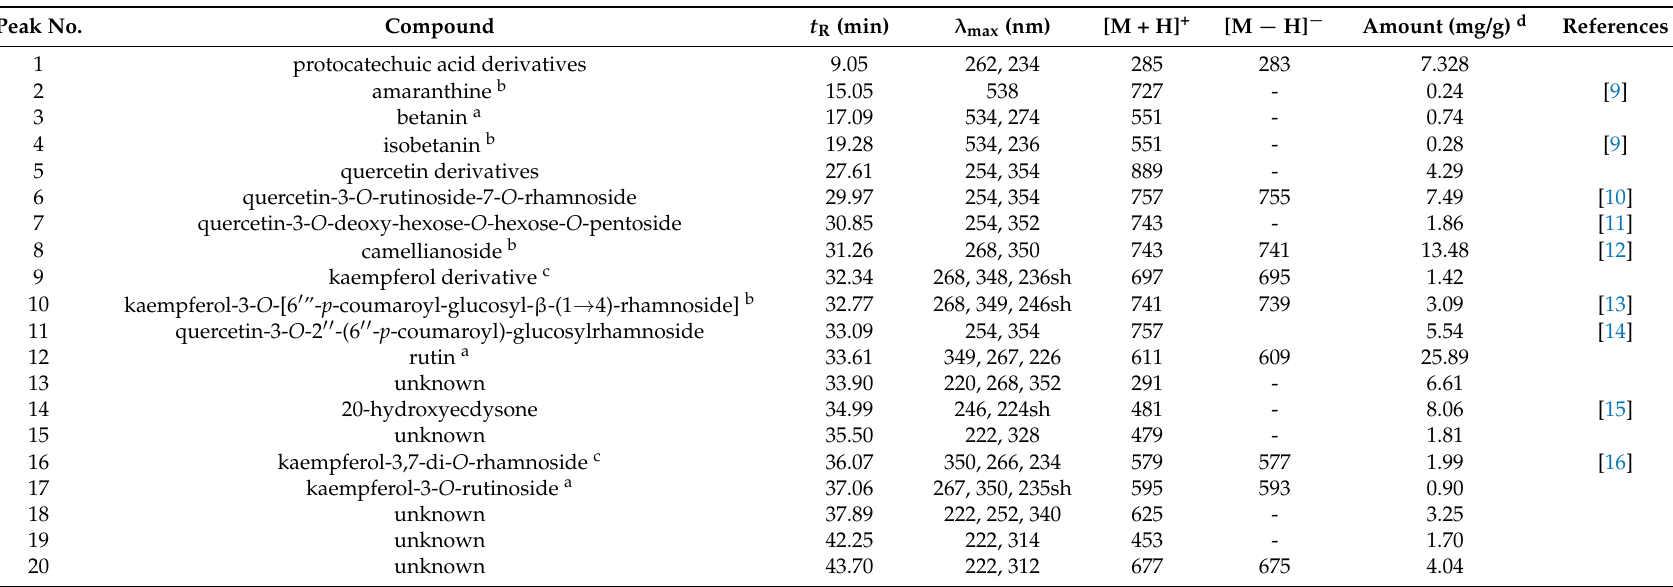
Table 1. Retention time, UV-Vis and Mass spectral characteristics of the ethanol extract of Djulis ( Chenopodiun formosaneum ). Peak